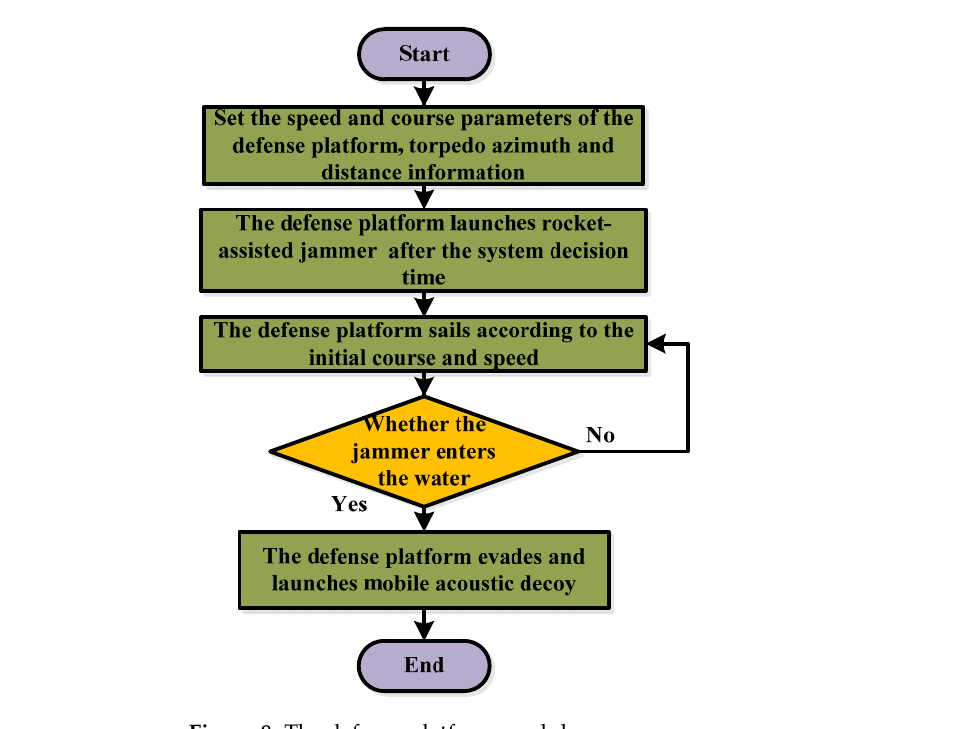
Figure 8. The defense platform module